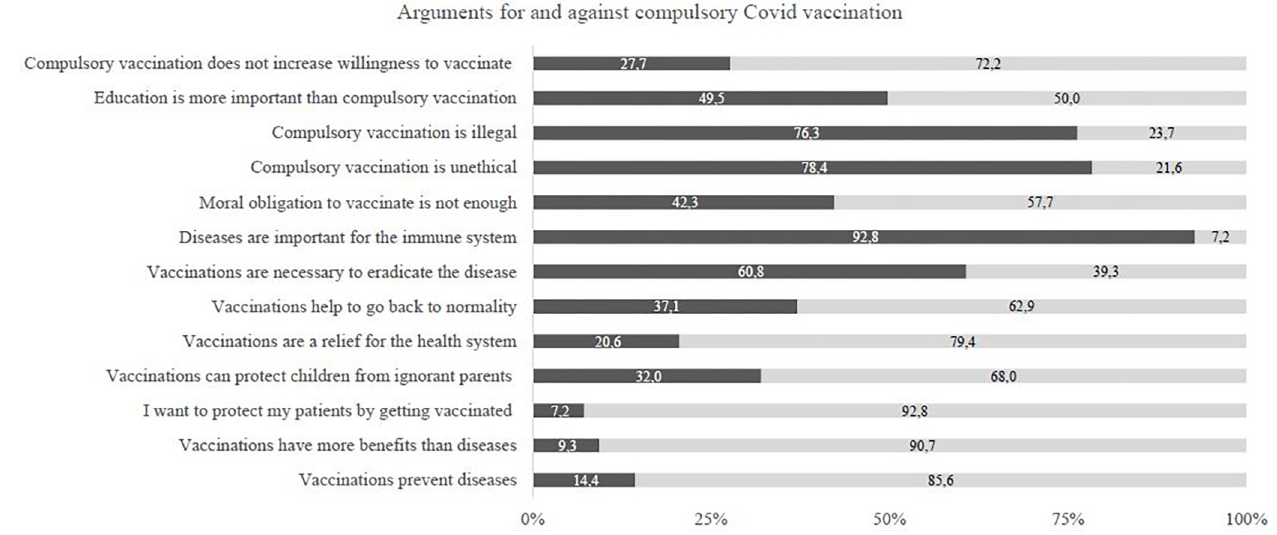
Fig 1. Arguments for and against compulsory Covid–19 vaccination of medical students within in the pandemic.